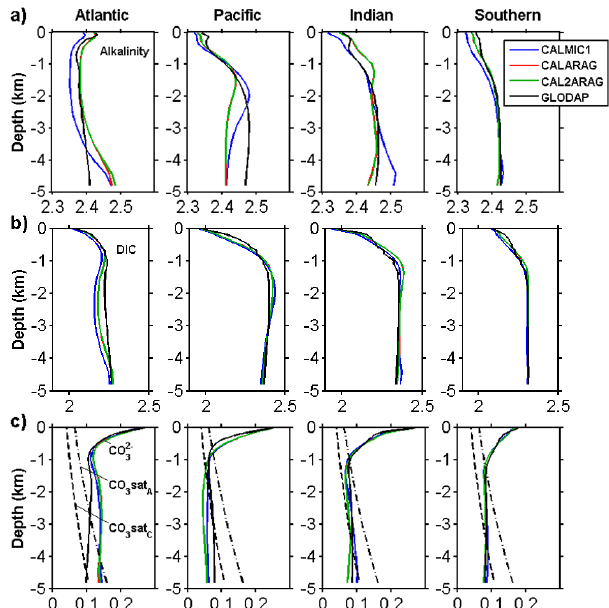
Fig. 7. Depth profiles for (a) alkalinity (molm − 3 ), (b) DIC (molm − 3 ), and (c) CO 2 − (molm − 3 ). Concentrations are shown for 3 the Bern3D/PISCES versions CALMIC1, representing calcite pro- duction by nanophytoplankton only (blue), CALARAG, represent- ing calcite and aragonite production (red) and CAL2ARAG, rep- resenting calcite production by nanophyto- and mesozooplankton and aragonite production (green). Observation-based estimates are shown by black solid lines (GLODAP; Key et al., 2004) and satura- tion concentrations for CO 2 − with respect to calcite and aragonite 3 are indicated by black, dashed lines.